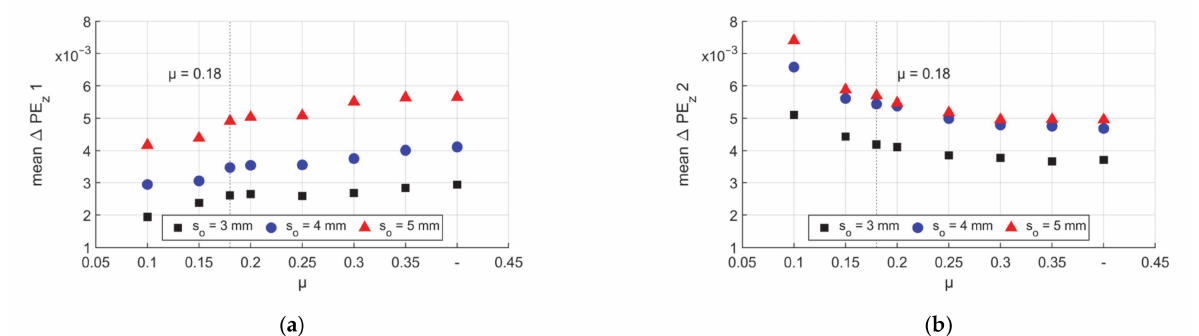
Figure 18. Mean values of axial ∆ PE z peaks, ( a ) Peak 1 and ( b ) Peak 2. The locations of the barycenter of Peak 1 are in the reduction zone and near the first contact, see Figure 19a. As seen in Figure 12, low µ led to a higher outer diameter, which results in an earlier contact, so the barycenter features with low z coordinate. For all µ amounts higher than the self–locking condition, the diameter was nearly not increased so the first contact was later at a higher z coordinate. The barycenter moved inside the reduction zone for friction coefficients up to µ = 0.2 while a higher µ led to a backward movement of the barycenter. With a high friction resistance, the workpiece was held even tighter by the dies and with higher µ the material flow on the die surface was impeded, thus the barycenter moved a little backward.